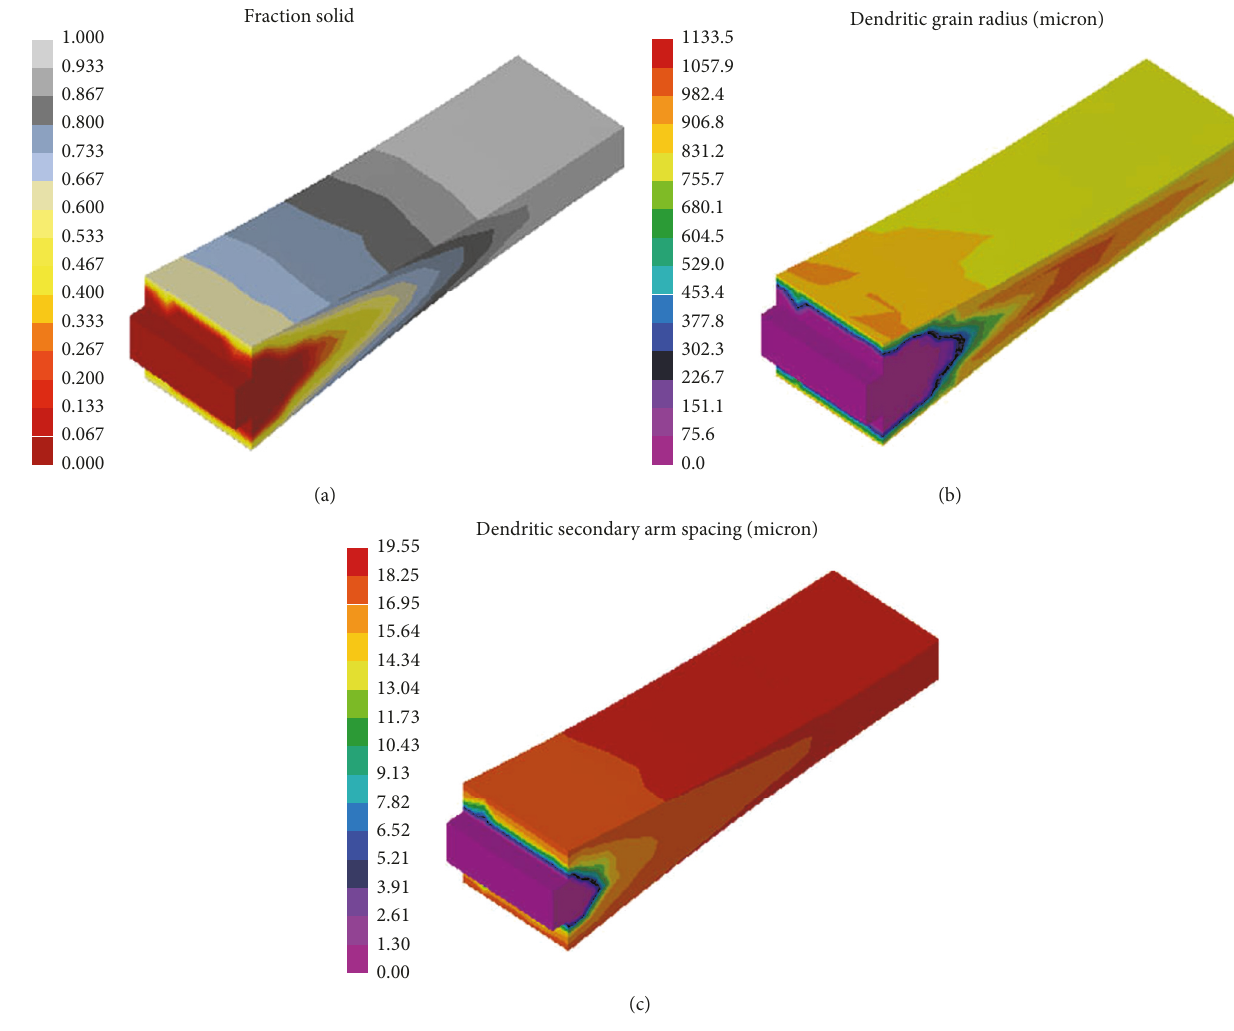
Figure 6: Solid fraction graph, dendritic grain radius graph, and secondary dendrite arm spacing graph of twin-roll cast Al-10Mg alloy wedge-shaped plate: (a) solid fraction graph; (b) dendritic grain radius graph; (c) secondary dendrite arm spacing graph.